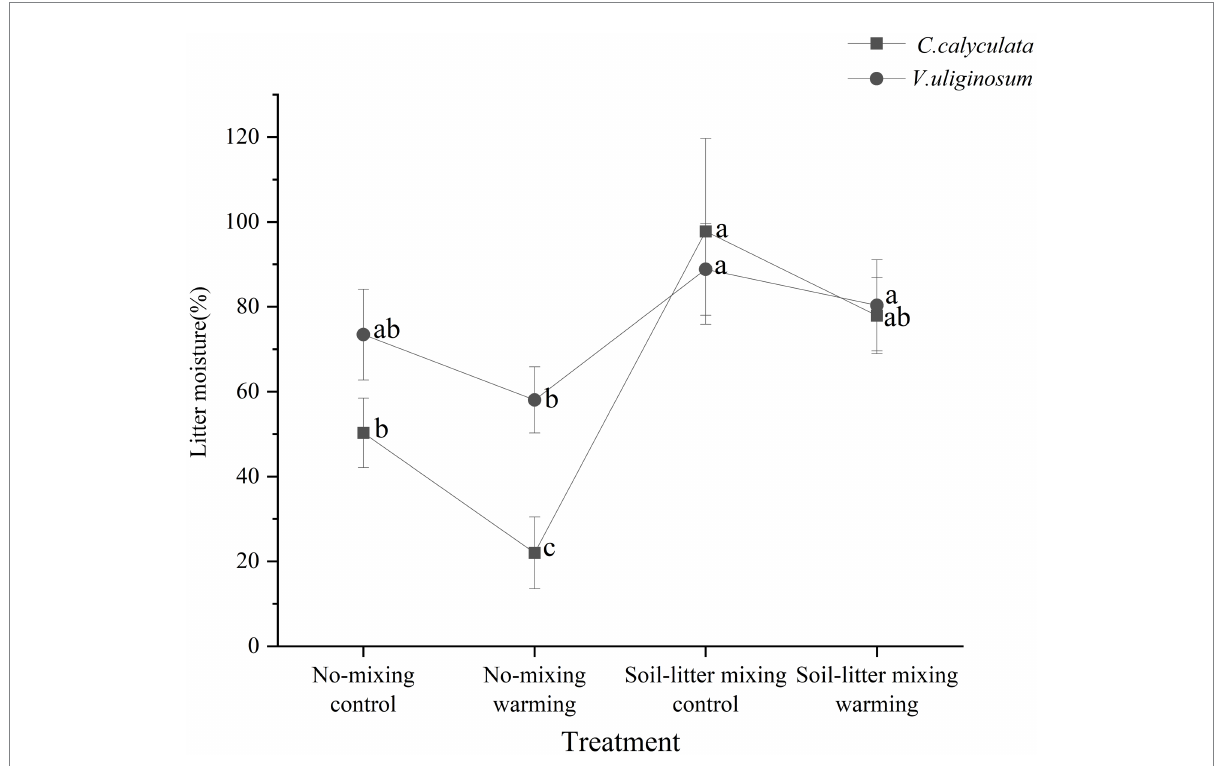
FIGURE 6 The moisture content of C. calyculata (square) and V. uliginosum (circle) litter at the end of the incubation. The letters represent significant differences among the four treatments (Bonferroni multiple comparison tests, p < 0.05). The error bars indicate the standard